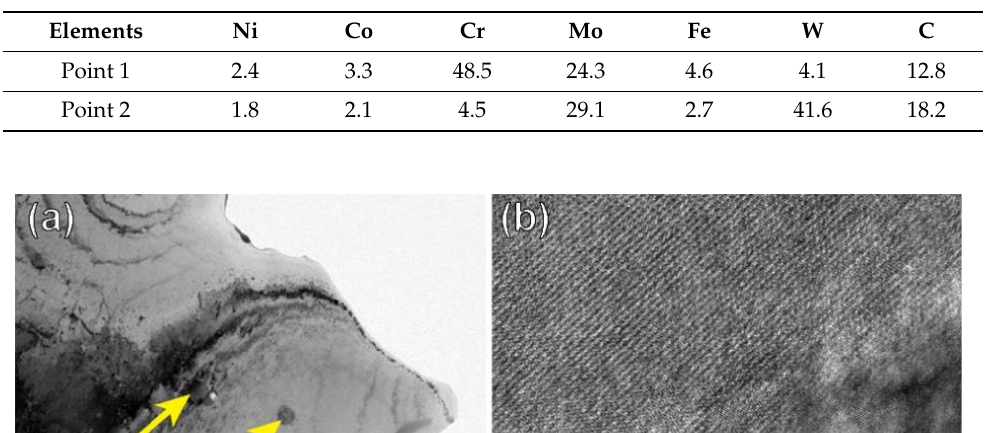
Table 4. Chemical compositions of carbides (at.%).